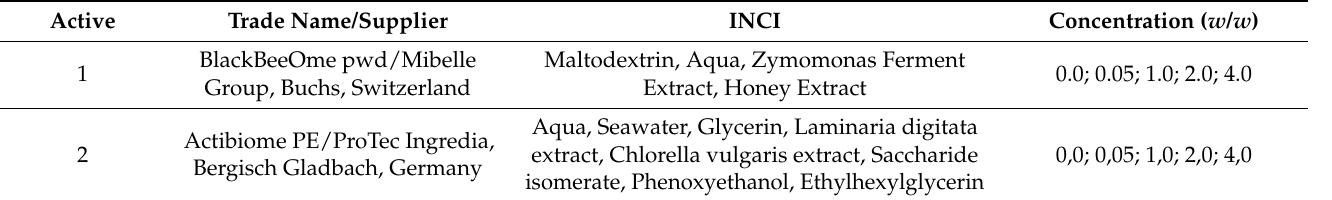
Table 2. Serum without added active ingredients served as the control. Table 2. Composition and concentration of active